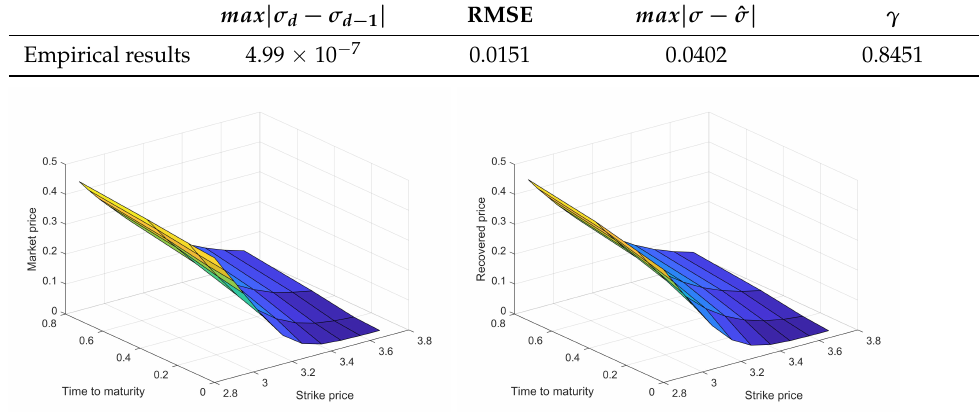
Table 5. The calibration results for SSE 50ETF option.